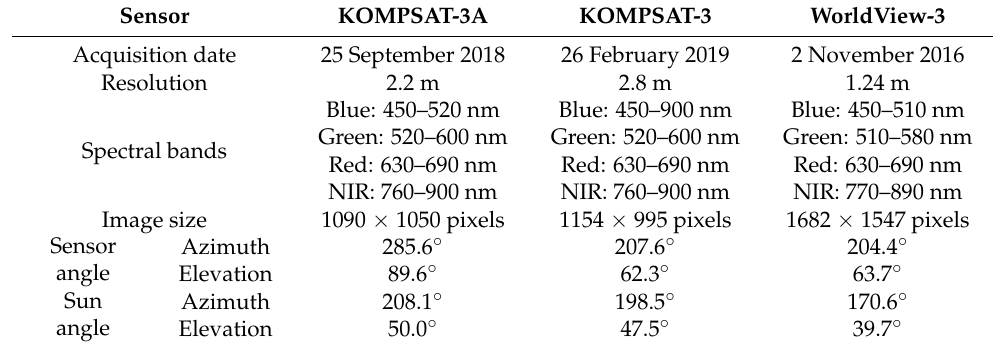
Table 1. Specification information of the sensors.